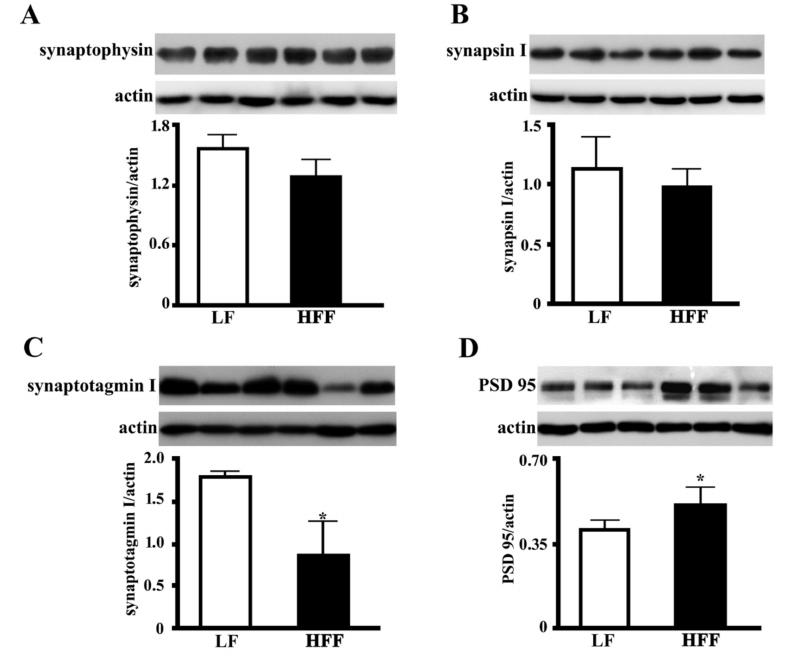
Figure 11. Protein content (with representative western blot) of presynaptic proteins synaptophysin ( A ), synapsin I ( B ) and synaptotagmin I ( C ), and postsynaptic protein PSD-95 ( D ) in the frontal cortex from middle-aged rats fed low fat (LF) or high fat-high fructose (HFF) diets for four weeks. Values are the means ± SEM of eight rats. * p < 0.05 compared to low-fat diet (two-tailed Student’s